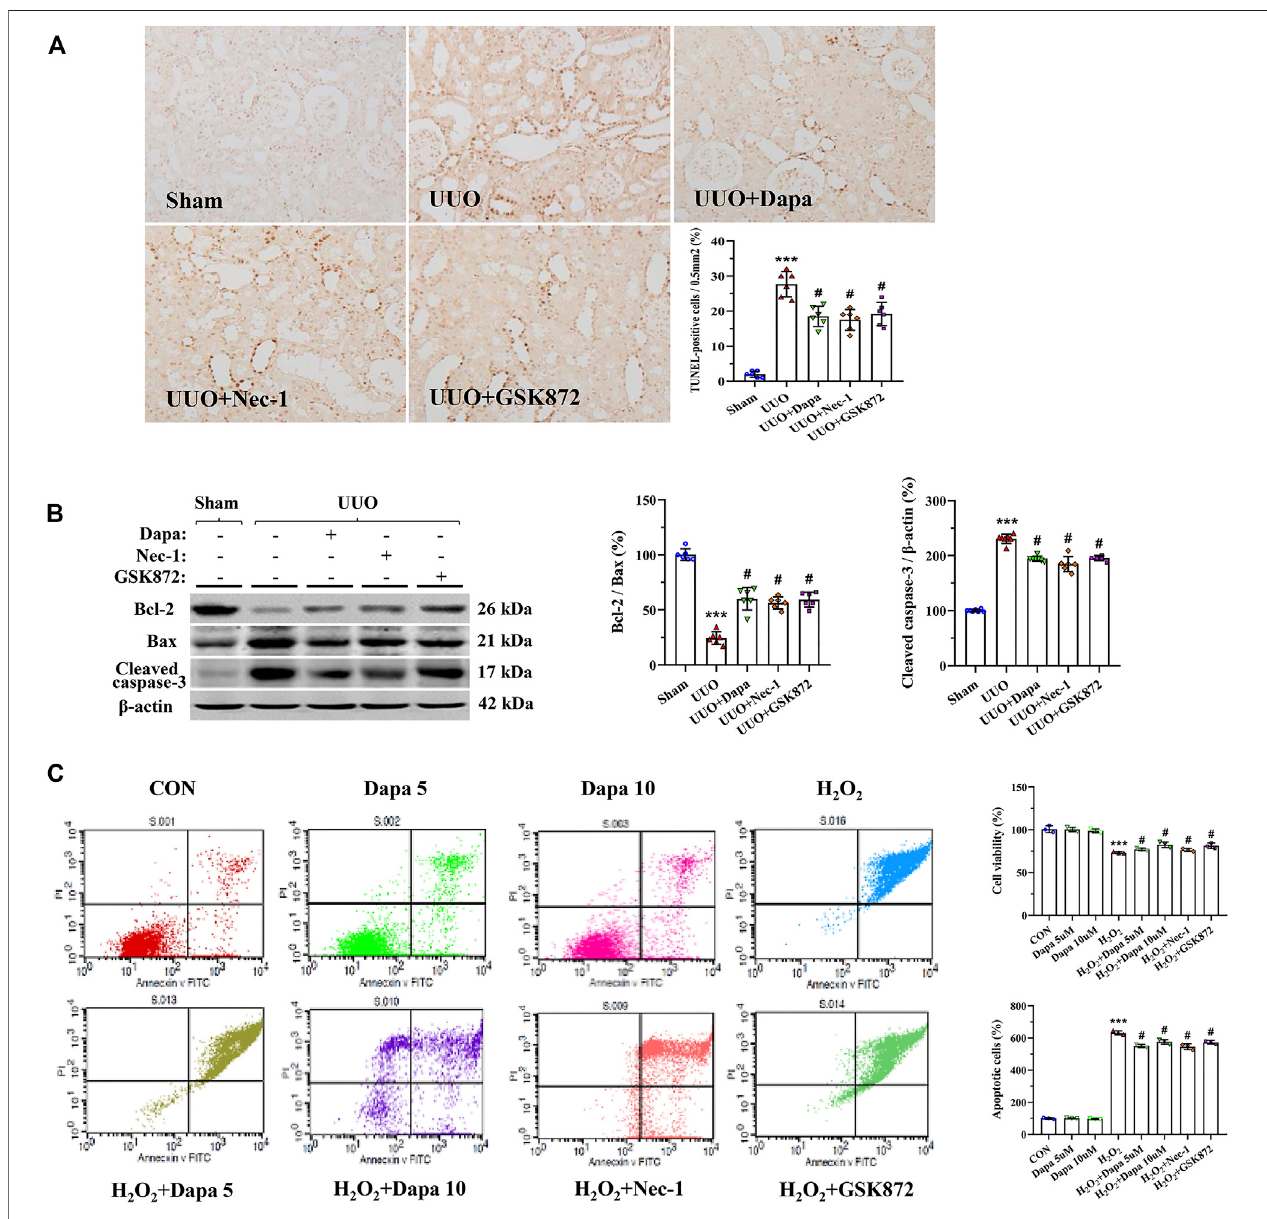
FIGURE 6 | Representative photomicrographs of the TUNLE assay (A) , immunoblotting analysis of apoptosis-related genes (B) , and apoptotic cell death and cell viabilityinHK-2cells (C) .Dataarepresented asmean ± SEM( invivo , n (cid:2) 6; invitro , n (cid:2) 3)andanalyzedbyone-wayANOVA. *** p < 0.01vsshamorcontrol; # p < 0.05vs UUO or H 2 O 2